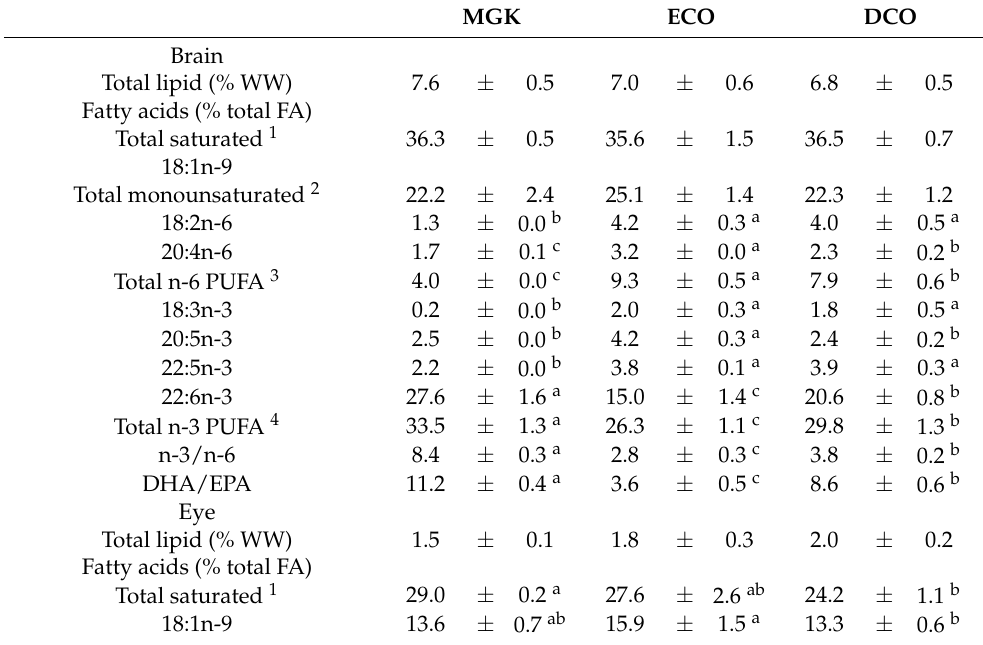
Table 6. Total lipid contents (% wet weight) and fatty acid compositions (% of total fatty acids) of brain and eyes of Atlantic bluefin tuna ( Thunnus thynnus L.) after 18 days of feeding the experimental feeds containing GM Camelina sativa oils with either high EPA (ECO) or EPA + DHA (DCO) compared to the commercial reference diet